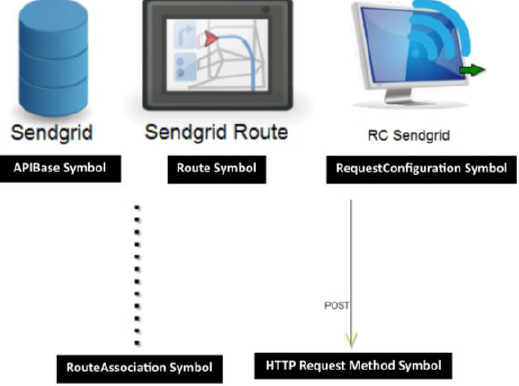
Figure 4. The graphical notations of the modeling